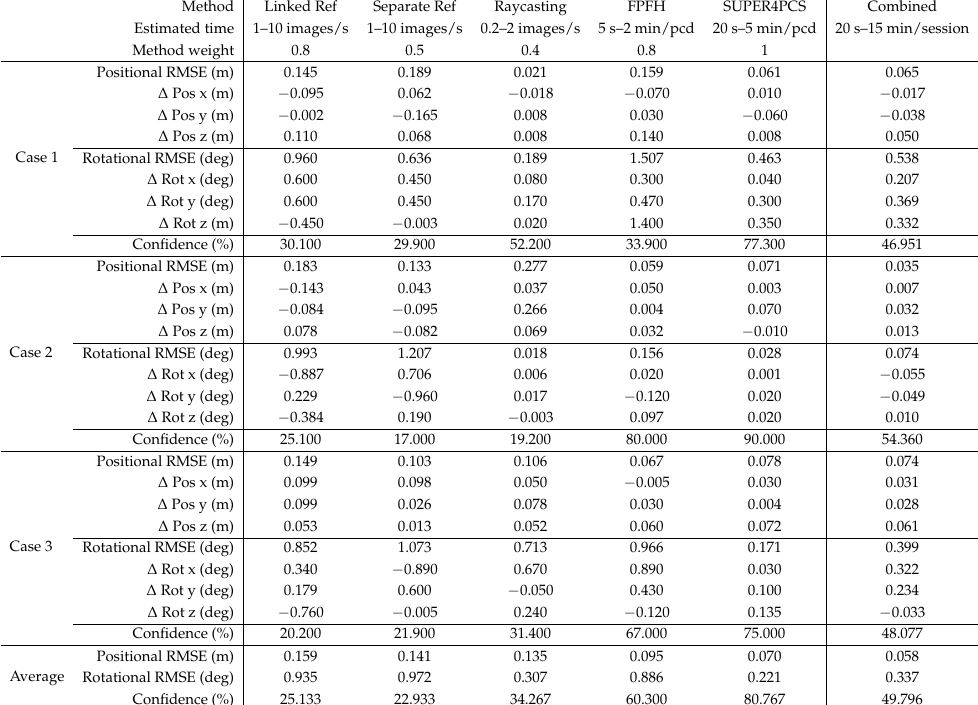
Table 9. Positional and rotational results and the confidence of each method across the sessions of each test